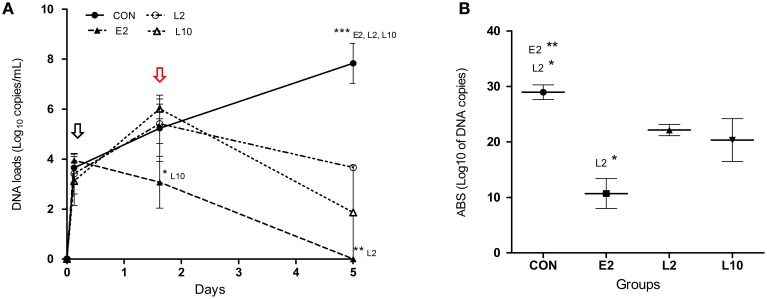
Mean titers (qPCR, Roche Light Cycler 480, standard 2nd derivative method) of M. haemolytica DNA copies (with standard deviations) in bronchoalveolar lavages (A) and mean accumulated bacterial shed (B) in calves treated with 2 mg/kg (E2) marbofloxacin at 4 h after inclusion or 2 mg/kg (L2) or 10 mg/kg (L10) marbofloxacin at 36 h after inclusion. The black and red arrows indicate the time of early and late treatments respectively. Significant differences: *p < 0.05; **p < 0.01; ***p < 0.001.